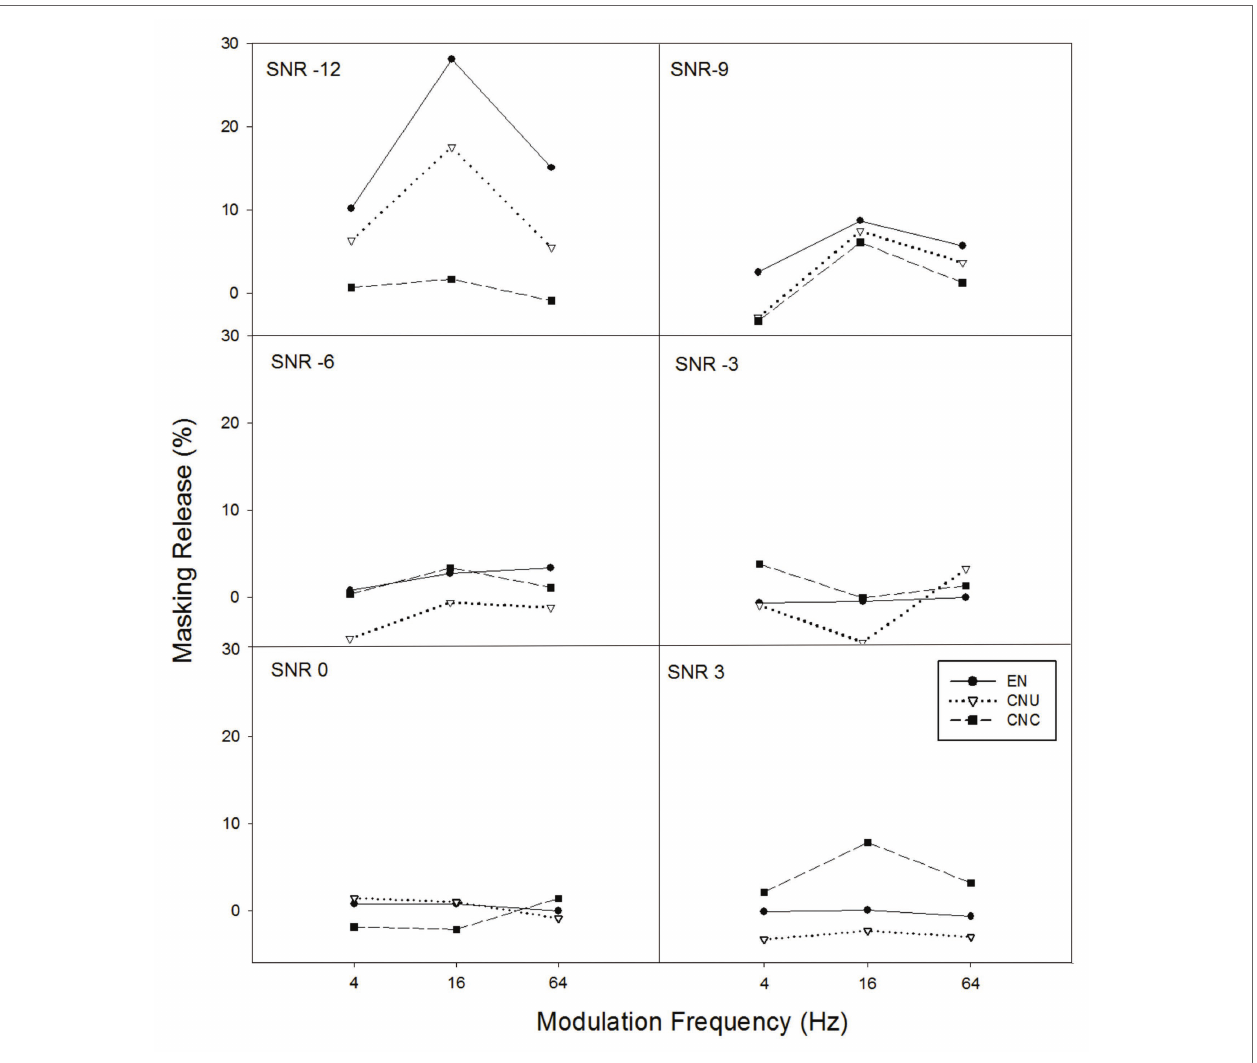
FIGURE 2 | The masking release from the temporal modulation of noise in percent (e.g., scores in temporally-modulated noise minus scores in stationary noise) as a function of temporal modulation frequency of noise for six SNRs (−12, −9, −6, −3, 0, and 3 dB for each panel) for three groups of listeners: EN listeners, CNU, and